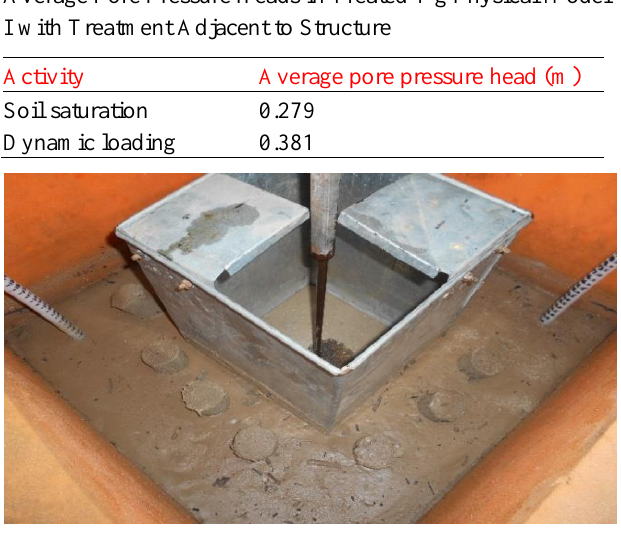
Fig. 6. Columns rotated after the application of dynamic loading